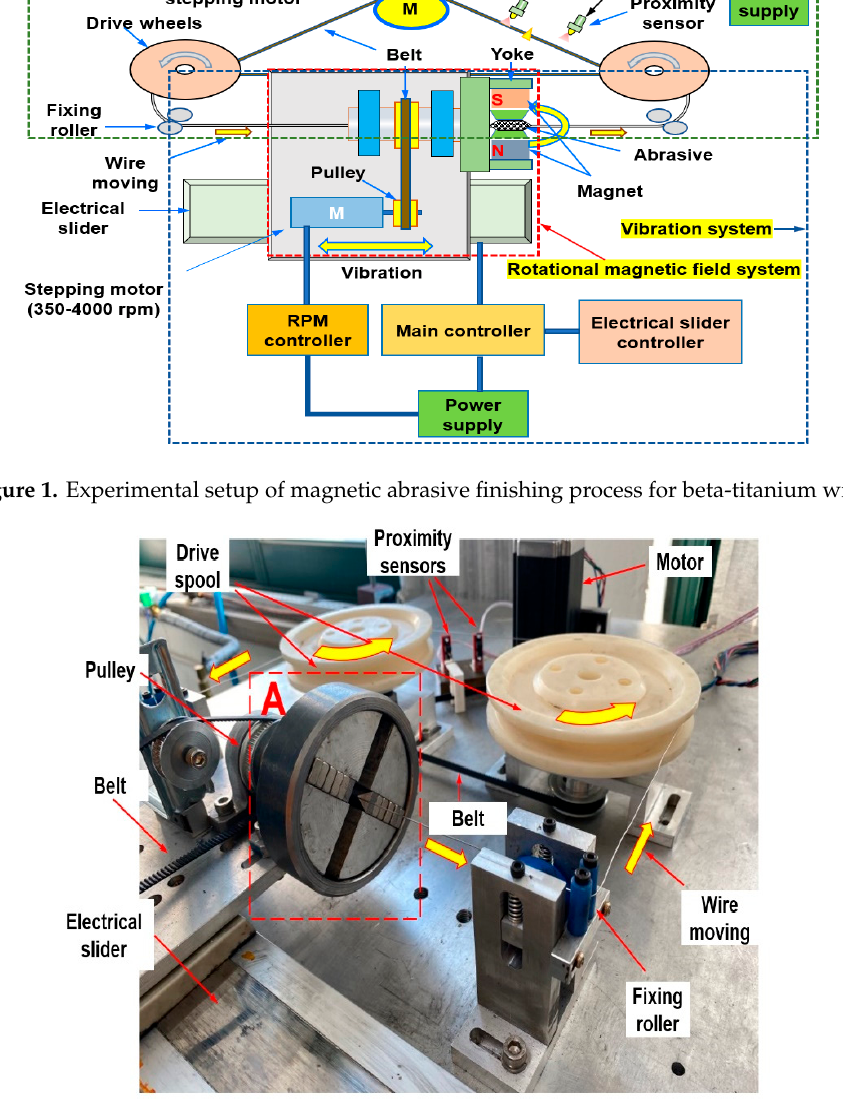
(a) (b) Figure 3. Schematic view of rotating magnetic field generator for beta-titanium wire: ( a ) 3D view of rotational magnetic field device and ( b ) 2D dimensional view of the rotational magnetic field device. 2.2. Beta-Titanium Wire Material Compared with stainless steel wires, beta-titanium wire material has lower force magnitudes, lower elastic modulus, higher spring back (maximum elastic deflection), lower yield strength, and good ductility, weldability, and corrosion resistance. Its formability and weldability are advantages over Ni-Ti alloys [17]. Due to its excellent mechanical properties, it has been used in medical applications, sport applications, and as frames for eyeglasses. Therefore, beta-titanium wire material was used in this study as the workpiece with a diameter of 0.5 mm and a length of 50 mm. The chemical composition and mechanical properties of the specimen are shown in Tables 1 and 2. Table 1. Chemical composition of β -titanium wire.